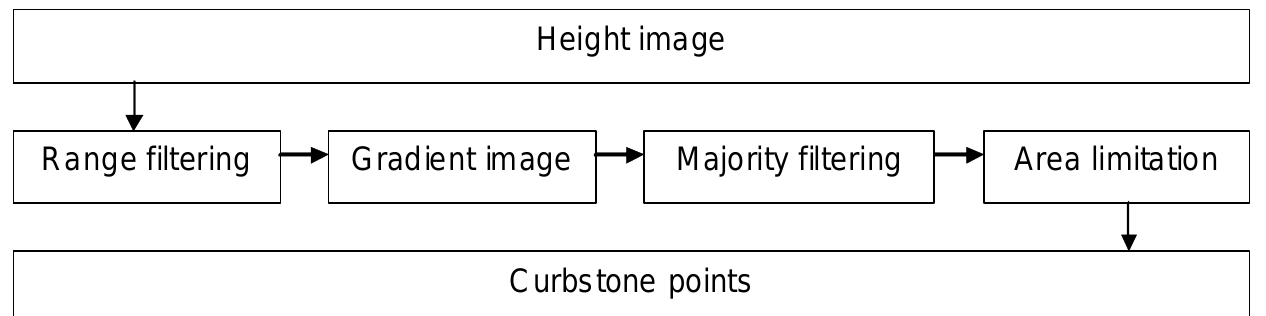
Figure 5. Curbstone modelling